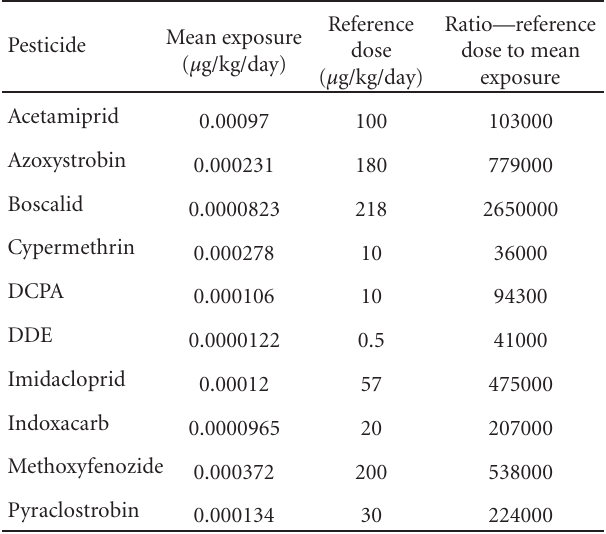
Table 6: Exposure estimates of the ten most frequently detected pesticides on cherries.